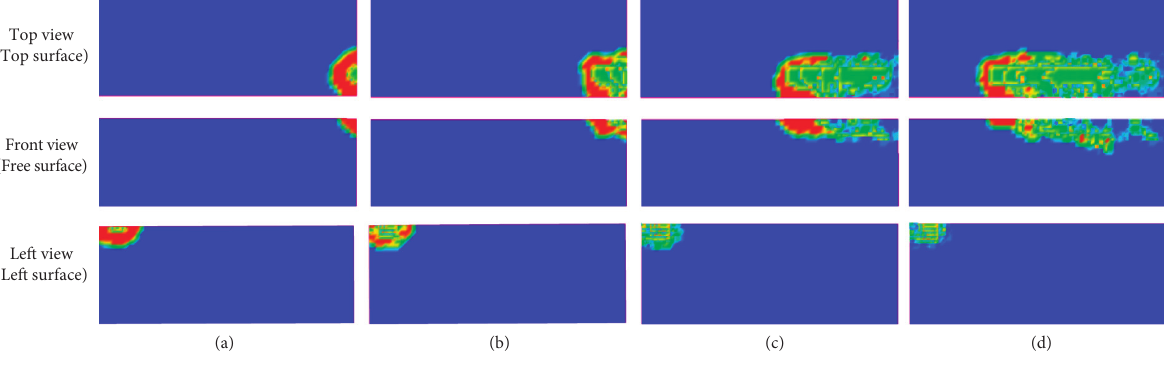
Figure 9: Damage nephogram of diamond cutting rock at fixed depth.